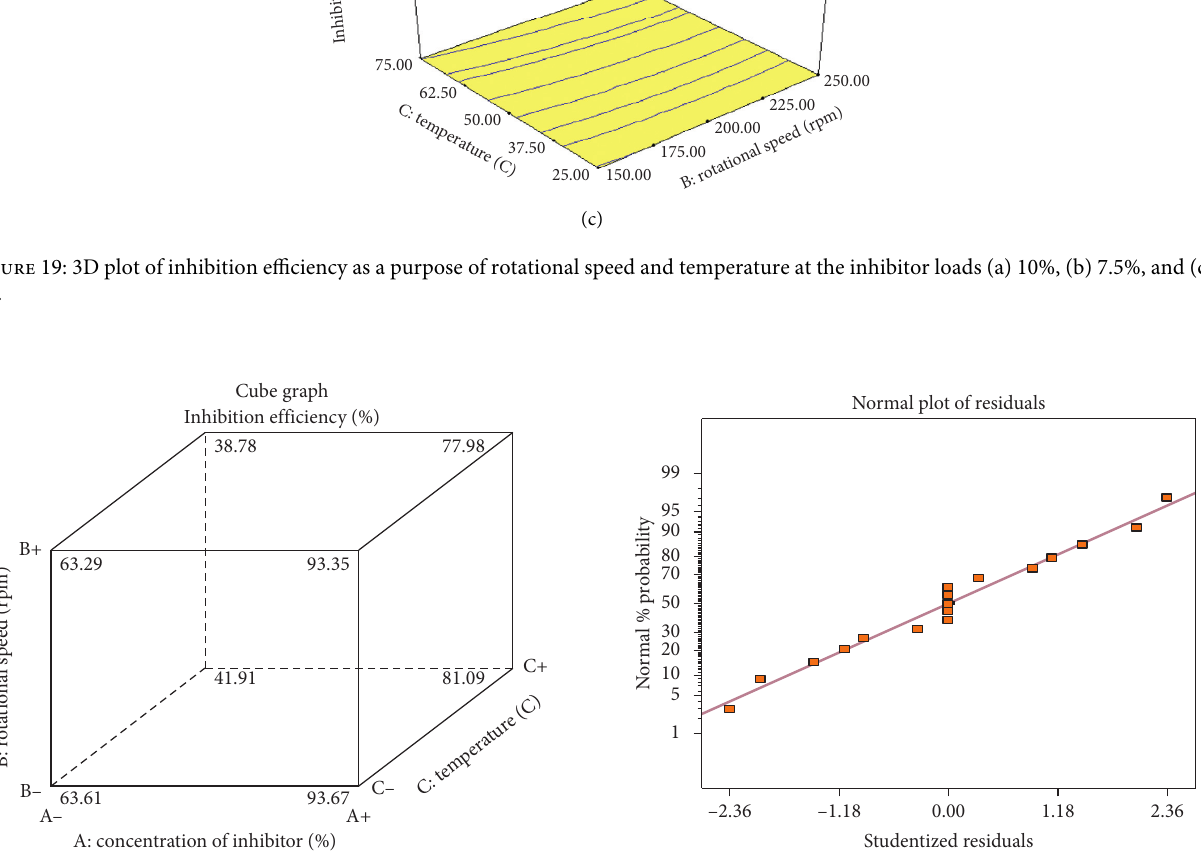
Figure 21: Normal plot of error distribution for inhibition